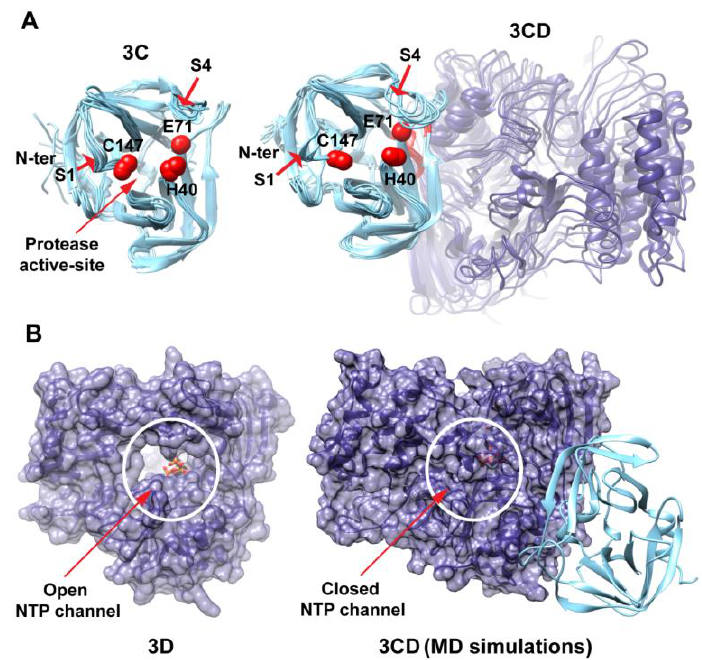
Figure 12. Influence of interdomain interactions on 3CD functions. ( A ) An ensemble of 3C conformations (left) obtained from MD simulations of 3C alone [51] and an ensemble of 3CD conformations (right) are shown. The catalytic triads of the protease active sites are indicated by red spheres; interface residues from 3C-domain in the precursor protein are colored red. MD simulations revealed that the N-terminal residues (aa 1–13), implicated in RNA binding, are much less dynamic in the context of 3CD than 3C alone. Whereas residues implicated in substrate binding or catalysis, including residues of pocket S1 (Thr-142, Gly-145 and Gln-146) and pocket S4 (Leu-125, Leu-127 and Phe-170), are more dynamic in the context of 3CD than 3C alone. These differences in dynamics may contribute to the unique specificity/activity of 3C relative to its precursor protein. Note that the 3D domain in 3CD can participate directly in interactions with polyprotein substrates, which may also contribute to the observed difference between the precursor and processed 3C protein. ( B ) Shown are the crystal structure of PV RdRp with the incoming NTP bound at the active site displayed as sticks (3D, PDB 3OL7 [26]), left, and the average 3CD structure from MD simulations, right. The two structures are oriented using the same view of the polymerase. The 3C and 3D domains are colored cyan and blue, respectively, and the polymerase domain is rendered as transparent surface. The NTP channel is circled and indicated by red arrow. In contrast to 3D structure in which the NTP channel is open, in 3CD the channel is closed and the nucleotide has no access to the active site of the polymerase. Also, interface residues in 3CD maintain interactions with the residues lining the NTP channel, interfering with its opening/closing motion. Additionally, the interdomain interactions in 3CD interfere with functionally important motions of the conserved structural motifs. All these differences in dynamics of 3D alone compared to that in the context of 3CD may contribute to the lack of polymerase activity in the precursor protein.